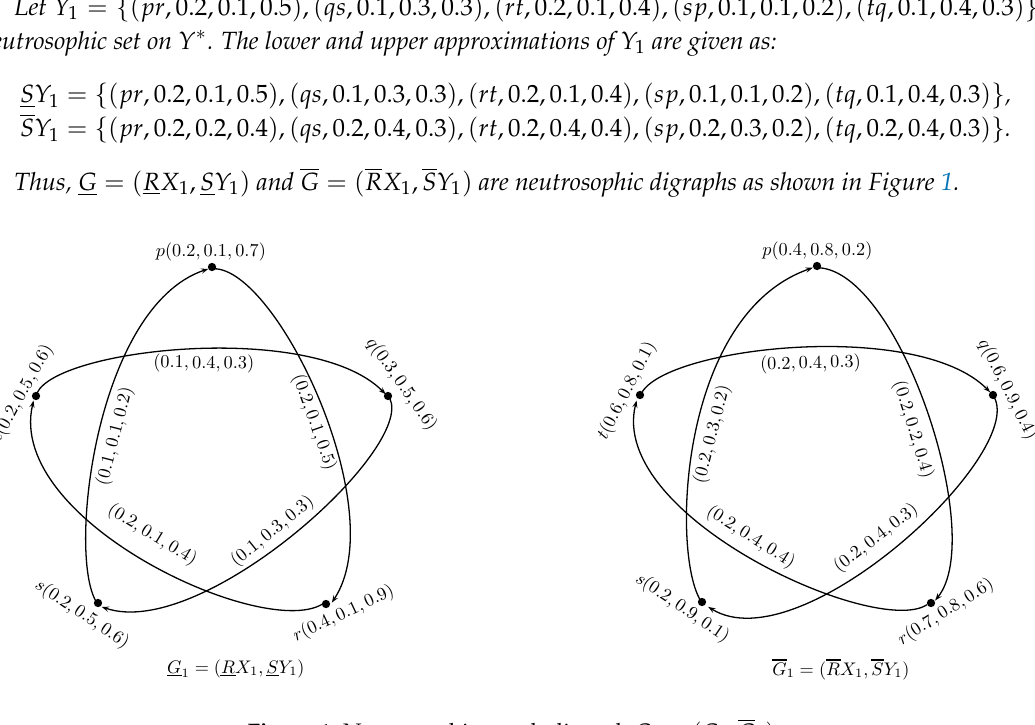
Figure 1: Neutrosophic Rough Digraph G 1 = ( G